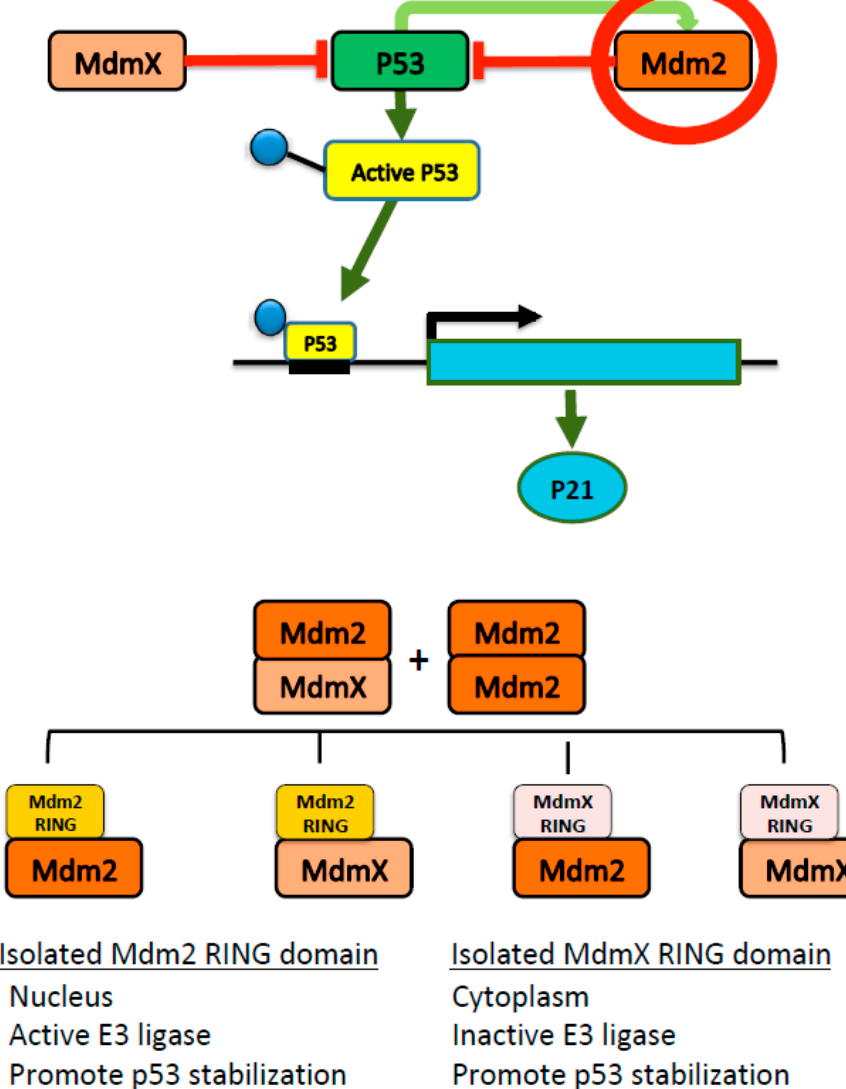
Figure 5. Cartoon scheme of p53-Mdm2-MdmX interplay. Aberrant overexpression of Mdm2 RING domain may dimerize with the full-length Mdm2 or MdmX resulting in inhibition of Mdm2 E3 ligase activity, MdmX stabilization and impaired p53 transcription.